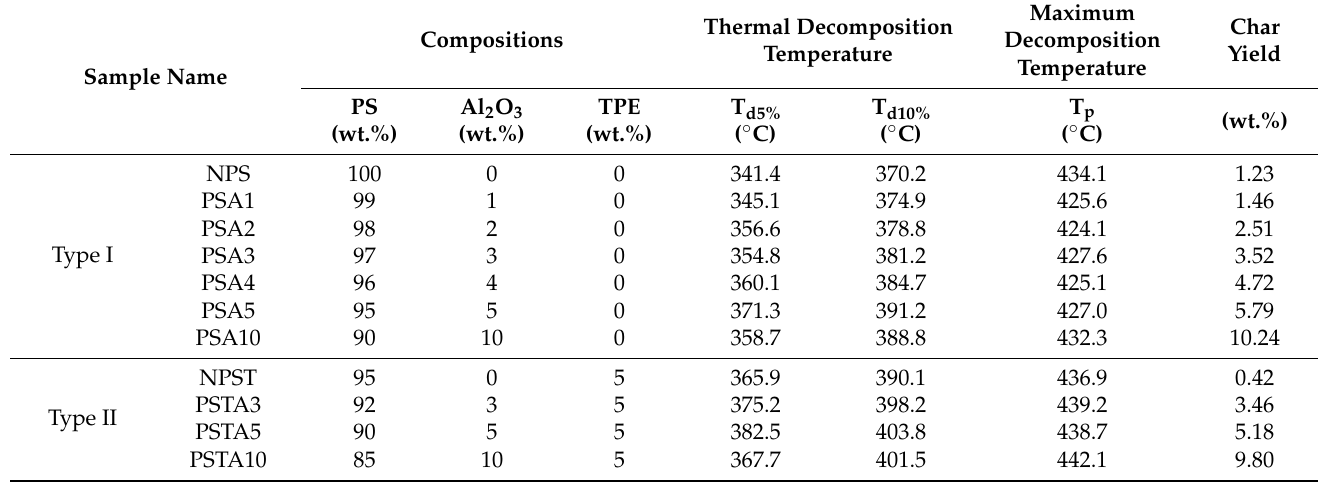
Table 2. The important parameters obtained from TGA measurements of samples prepared in this study.